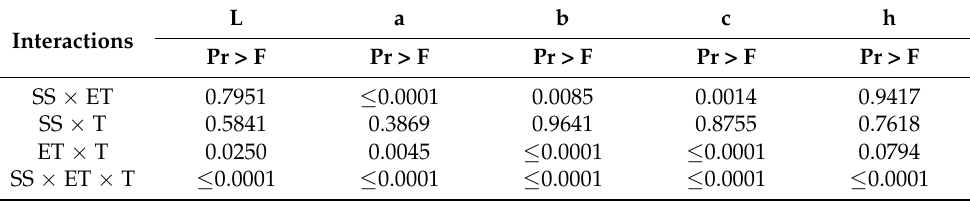
Table 2. Significance analysis of interactions of experiment factors for chromaticity parameters.